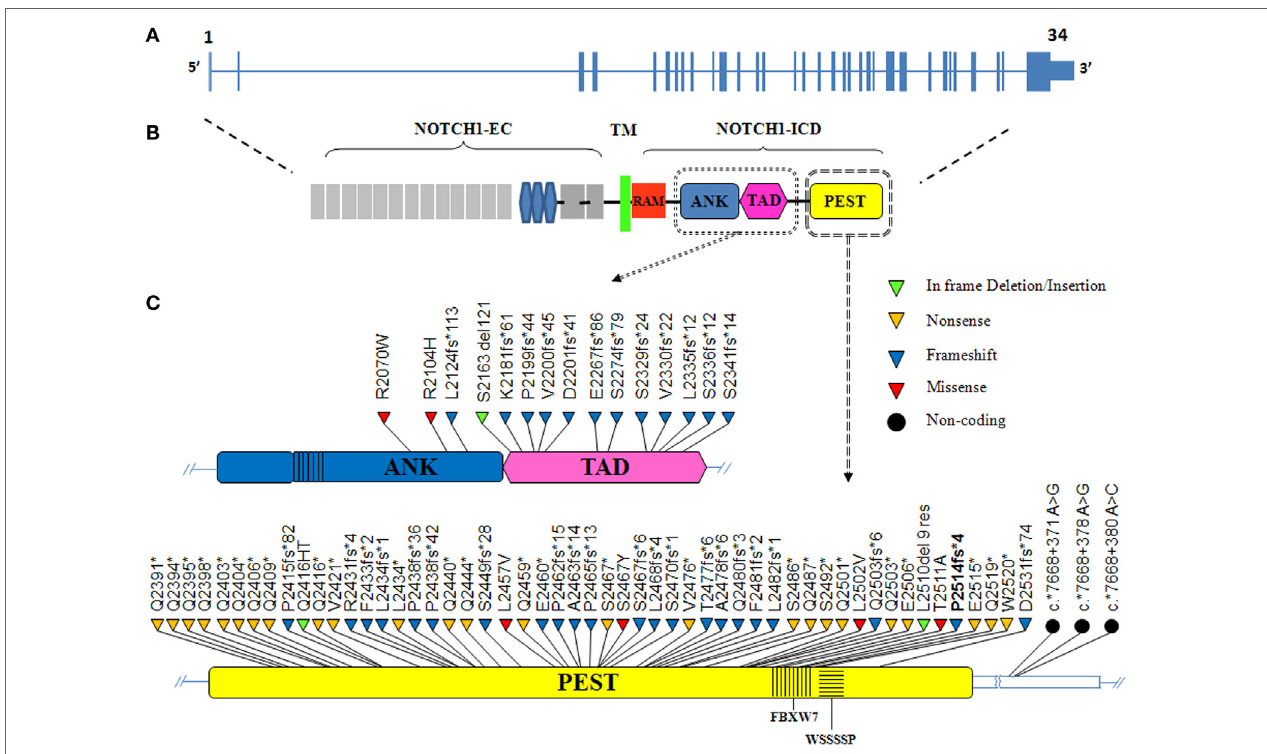
FigURe 2 | The distribution of NOTCH1 mutations in chronic lymphocytic leukemia (CLL). (A) Schematic diagram of the human NOTCH1 gene consisting of 34 exons (vertical bars) and spanning 50 kb. (B) The NOTCH1 protein includes an extracellular domain (EC) and an intracellular domain (ICD) linked by a transmembrane portion (TM). The NOTCH1-ICD consists of RBPJ-associated molecule (RAM) and ankyrin (ANK) domains involved in CSL/RBP-Jk binding, a transactivation domain (TAD) and a PEST (polypeptide enriched in proline, glutamate, serine and threonine) domain, which is a hotspot for mutation in CLL. (C) The ANK/TAD (upper panel) and PEST (lower panel) domains are magnified, and the color-coded shapes indicate the position of the in frame deletion/insertion (green), non-sense (yellow), frameshift (blue), missense (red), and non-coding (black dot) mutations found in CLL. The F-box and WD repeat domain-containing 7 (FBXW7) and WSSSSP degron are indicated within the PEST